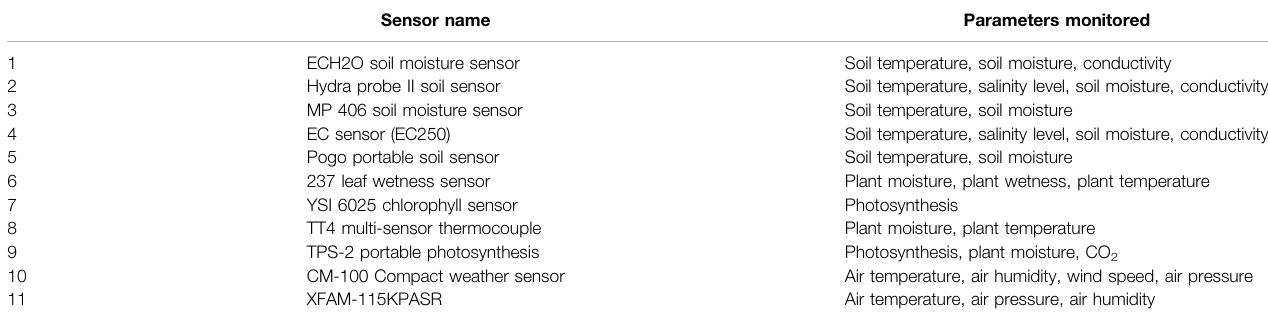
TABLE 1 | Common sensors and detection parameters in agriculture (Abbasi et al., 2014).